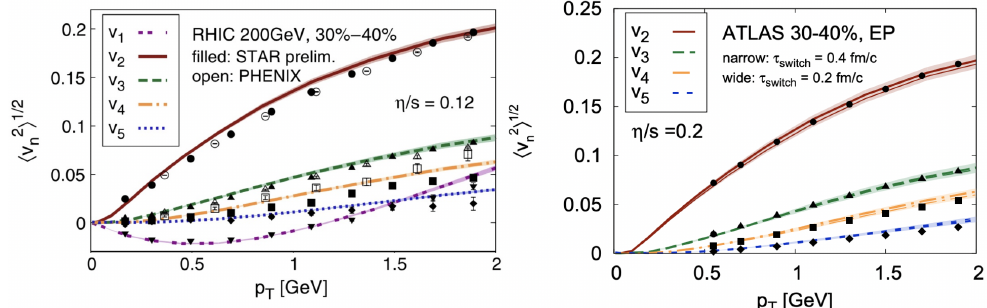
Figure 3. The PHENIX ( left , open symbols), STAR ( left , filled symbols) and ATLAS ( right ) root- mean-square anisotropic flow coefficients (cid:104) v 2 n (cid:105) 1/2 for the 30–40% centrality class compared with the IP-Glasma + MUSIC model [14]. Reprinted with permission from American Physical